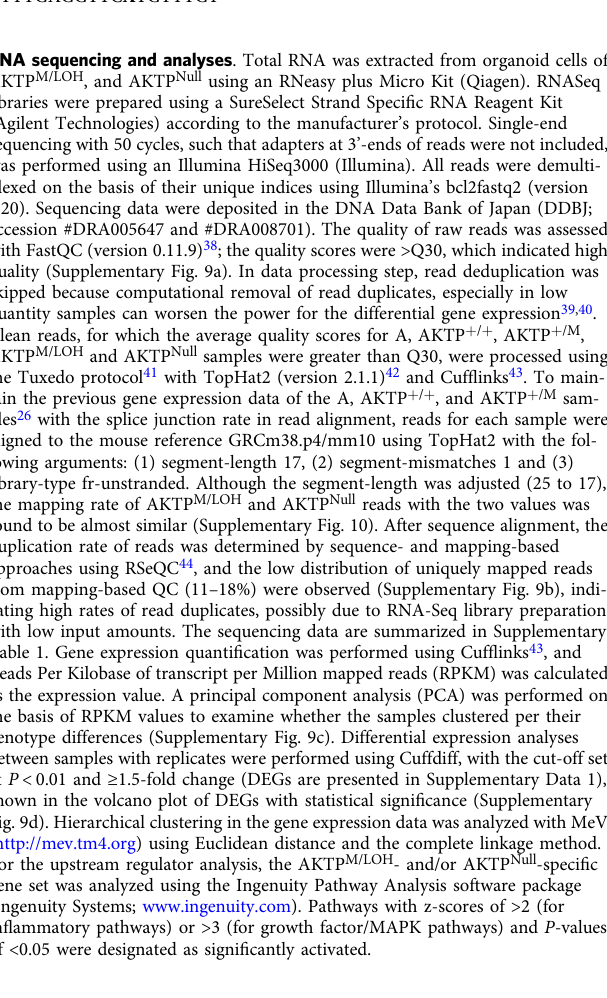
Table 1. Gene expression quanti fi cation was performed using Cuf fl inks 43 , and Reads Per Kilobase of transcript per Million mapped reads (RPKM) was